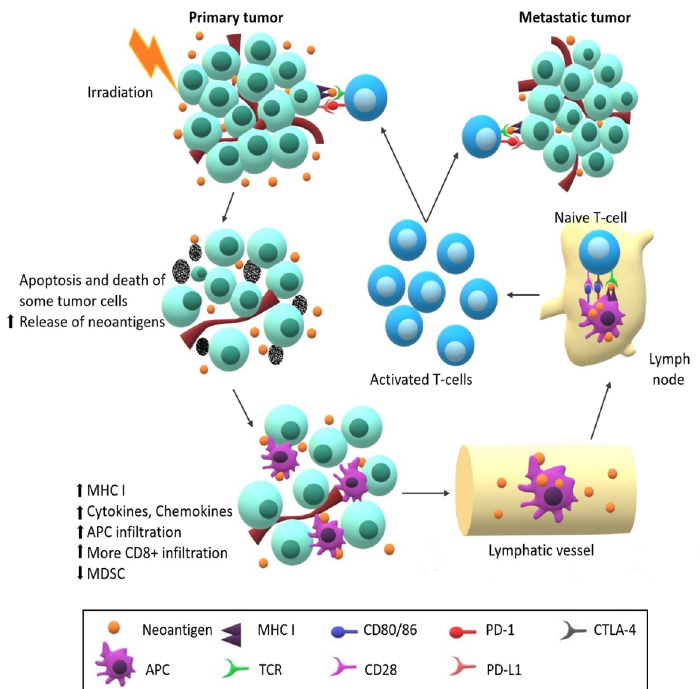
Figure 5. Scheme of Abscopal Effect. Irradiation of the cancer cells leads to apoptosis and immunogenic cell death, which contributes to higher release of tumor neoantigens. Radiation causes decrease of myeloid-derived suppressor cells (MDSCs), increased expression of major histocompatibility complex I (MHC I) on tumor cells and production of cytokines and chemokines attracting T-cells. Released neoantigens are up-taken by APCs, migrate through lymphatic vessels to lymphatic nodules, where they are presented to naïve T-cells by interaction of MHC I with T cell receptor (TCR). Naïve T-cells become activated upon further co-stimulatory signals, such as CD80, CD40 and CD28. Activated T-cells, mainly effector T-cells, proliferate and differentiate into neoantigen-specific cytotoxic T cell. These cells then migrate from lymph nodes and accumulate in the places with the neoantigen “label”, meaning all primary and metastatic tumor lesions. The abscopal effect could be hampered by presence of cytotoxic T-lymphocyte associated antigen 4 (CTLA-4) or programmed-death ligand 1 (PD-L1), which have immunosuppressive effect.